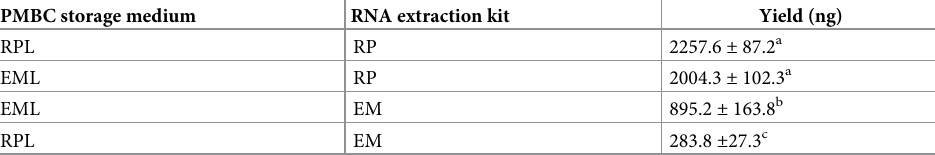
Table 4. RNA yield for the combinations of storage in EML and RPL and RNA extraction with EM and RP RNA extraction kits.